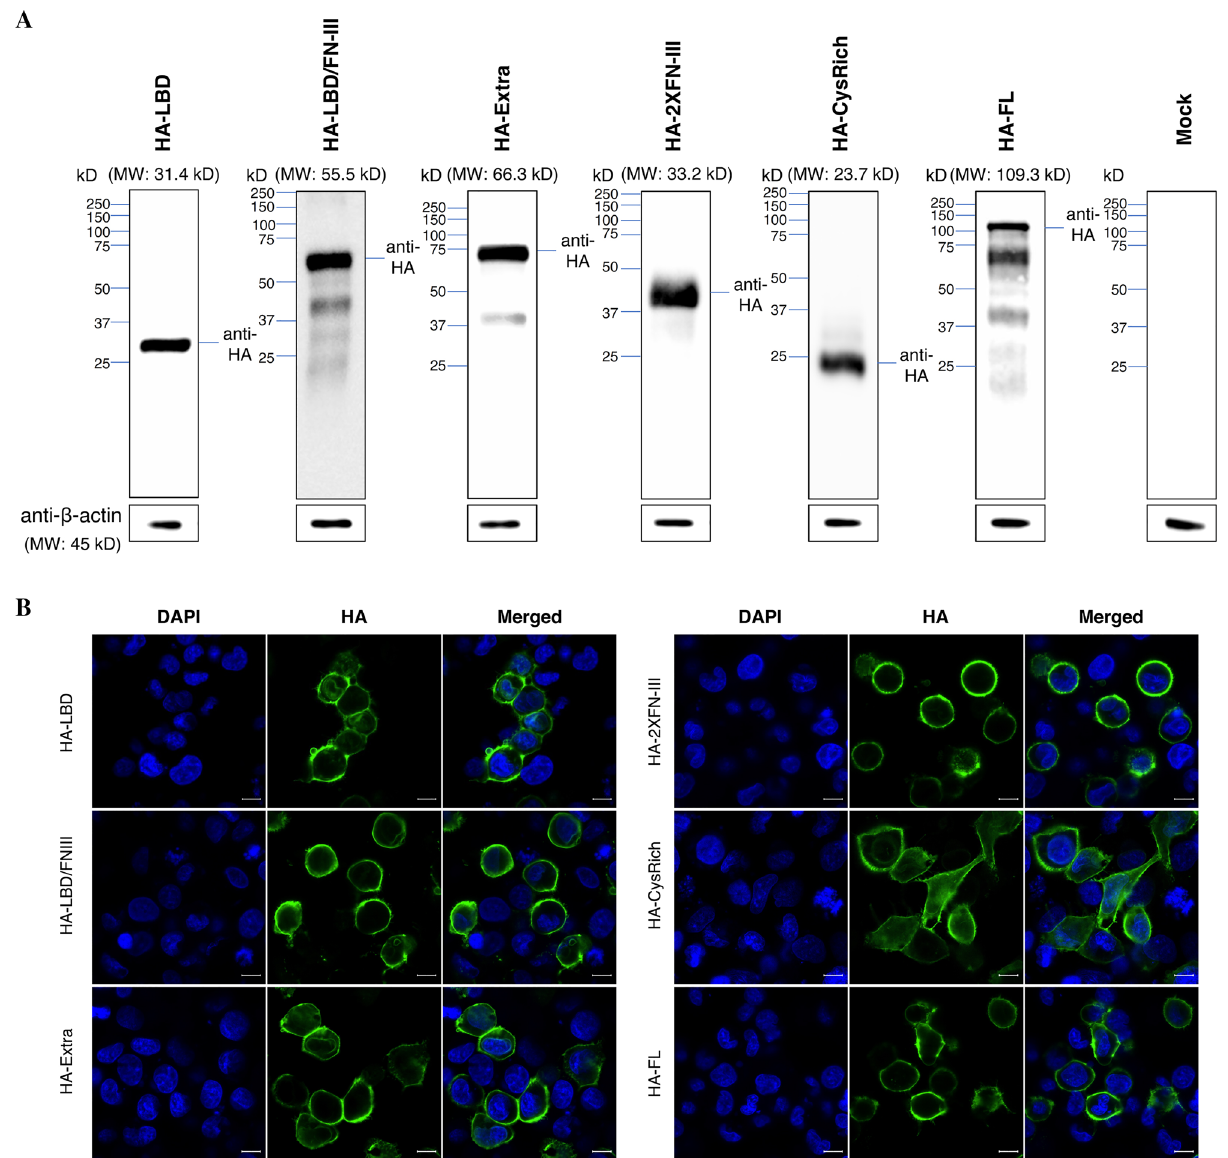
Figure 2. Transient expression of EphA2 constructs in HC-04 and the impact on P. vivax infection. ( A ) Western blot of the total cell lysates from HC-04 transfected with the indicated EphA2 construct. The EphA2 recombinant proteins were detected through the N-terminal HA-tag. These blots are not quantitative as different exposure were used to achieve best visual clarity. The β-actin control bands were cropped from different gels using the same respective cell lysis. ( B ) Representative IFA images of non-permeabilized HC-04 complemented with each EphA2 construct. EphA2 recombinant protein was detected by an HA-tag antibody (green). Nuclei (blue) were visualized with DAPI. Scale bar: 10 μm. ( C ) Fold increase of the liver-stage parasite infection in HC-04 expressing different EphA2 constructs. The numbers of liver-stage parasites were quantified by immunostaining with UIS4 antibody on day 4 post-infection. Error bars represent S.E.M. of 10 P. vivax clinical isolates. Different symbols represent different P. vivax clinical isolates. Asterisks mark significant differences from the mock transfection control; p -values were determined by two-way ANOVA (EphA2 construct and parasite isolate as variables) followed by Dunnett’s multiple comparisons EphA2 is functional for P. vivax infection without the endogenous TMD and the cytoplasmic portion, and that larger extracellular constructs appeared to have a more significant impact on sporozoite invasion. Interestingly, no enhancement was detected when the full-length construct (HA-FL) was used. This could be due to protein truncation or degradation, as indicated by the presence of multiple bands on Western blot (Fig. 2a). Generation of a new transgenic HC‑04 cell line with improved P. vivax susceptibility.